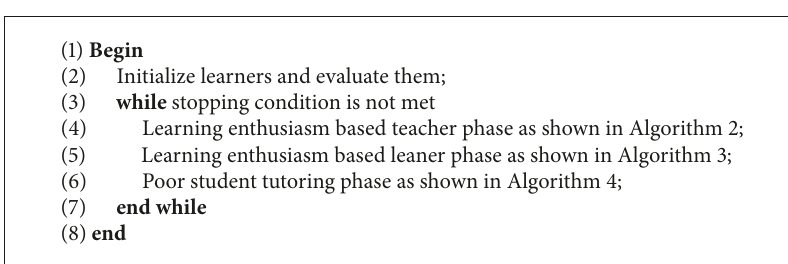
Algorithm 5: The LebTLBO